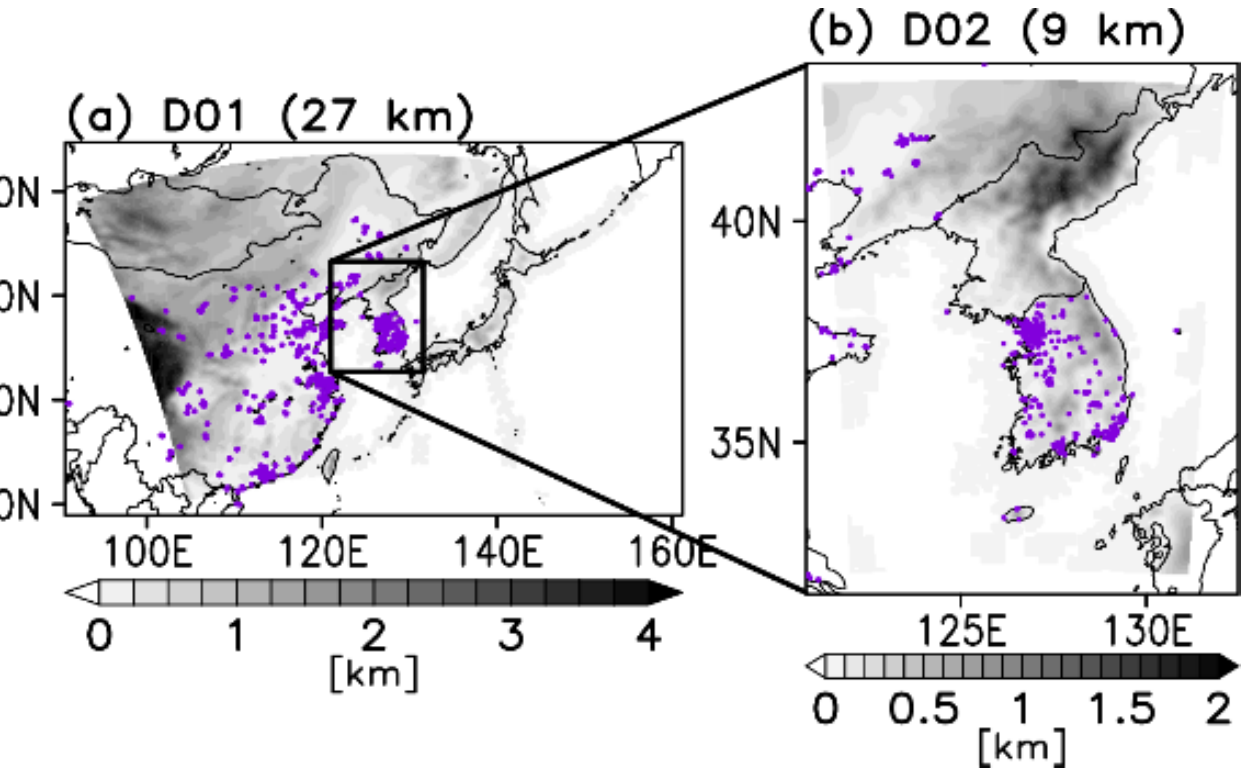
Figure 1. Simulation domain for WRF-Chem with surface elevation (shaded, unit: kilometer). ( a ) shows domain 1 (D01) and ( b ) shows domain 2 (D02). Purple dots indicate the locations of ground-based PM